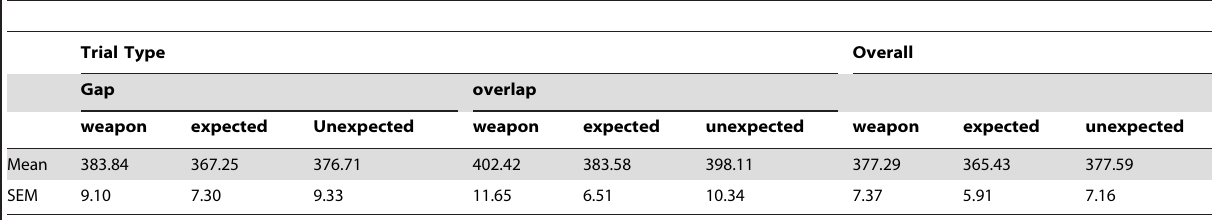
Table 2. Group means and standard errors of the saccadic reaction times (SRT) by object condition (weapon, expected and control) and trial type (gap and overlap) in Experiment 2, which employed the antisaccade gap-overlap